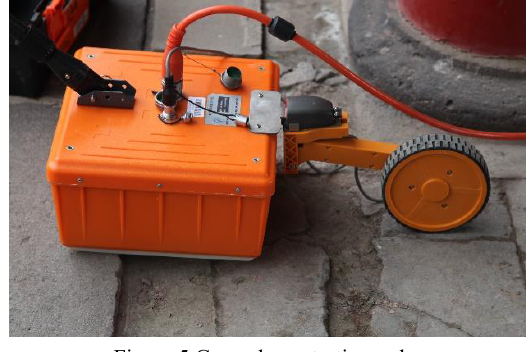
Figure 5 Ground penetrating